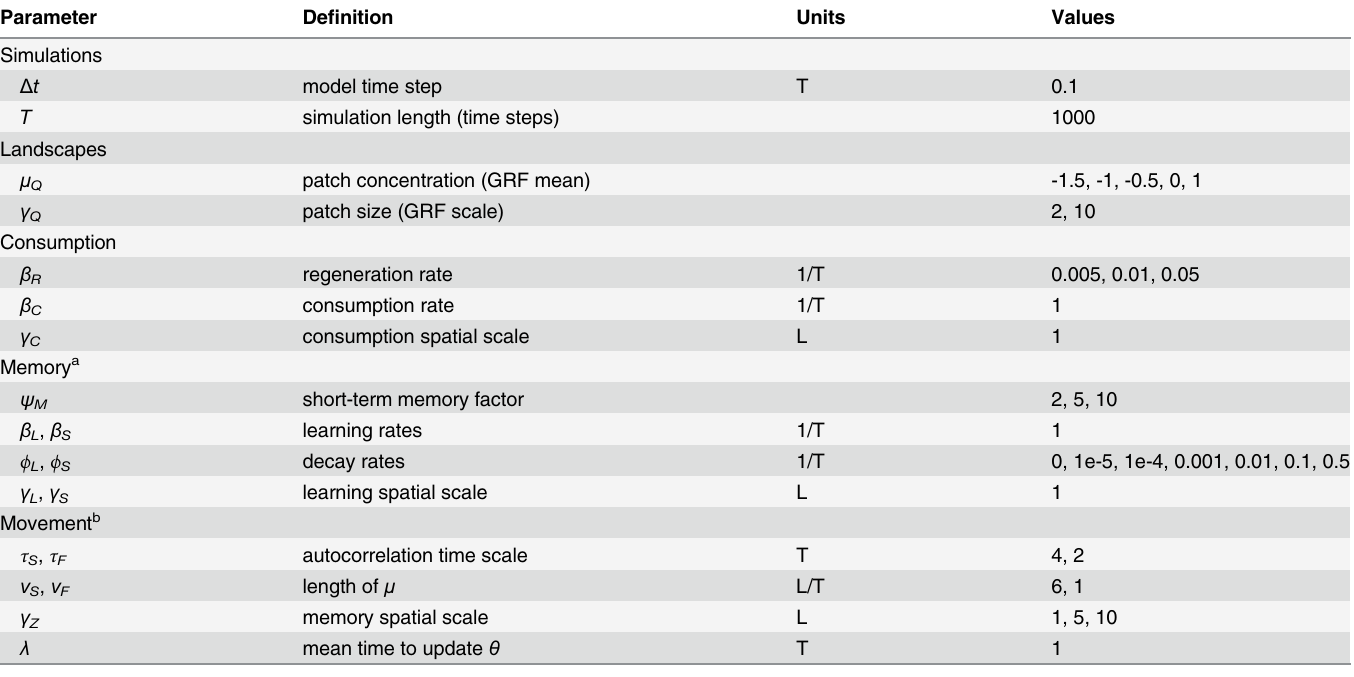
Table 1. Parameters used in the foraging model and values for simulations. Because units are arbitrary in the simulations, L is used for generic length units and T is used for generic time units.